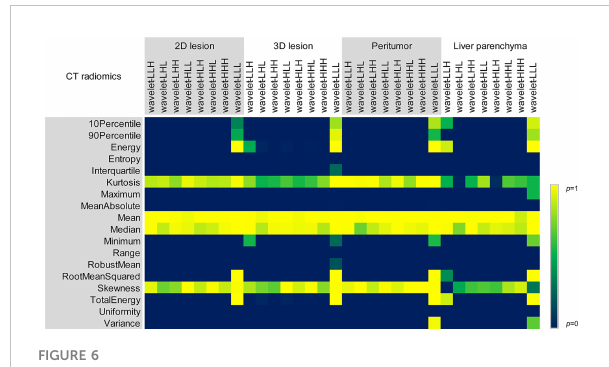
FIGURE 6 Comparison of p values of different reconstruction algorithms for wavelet features in 2D and 3D lesions, peritumor and liver